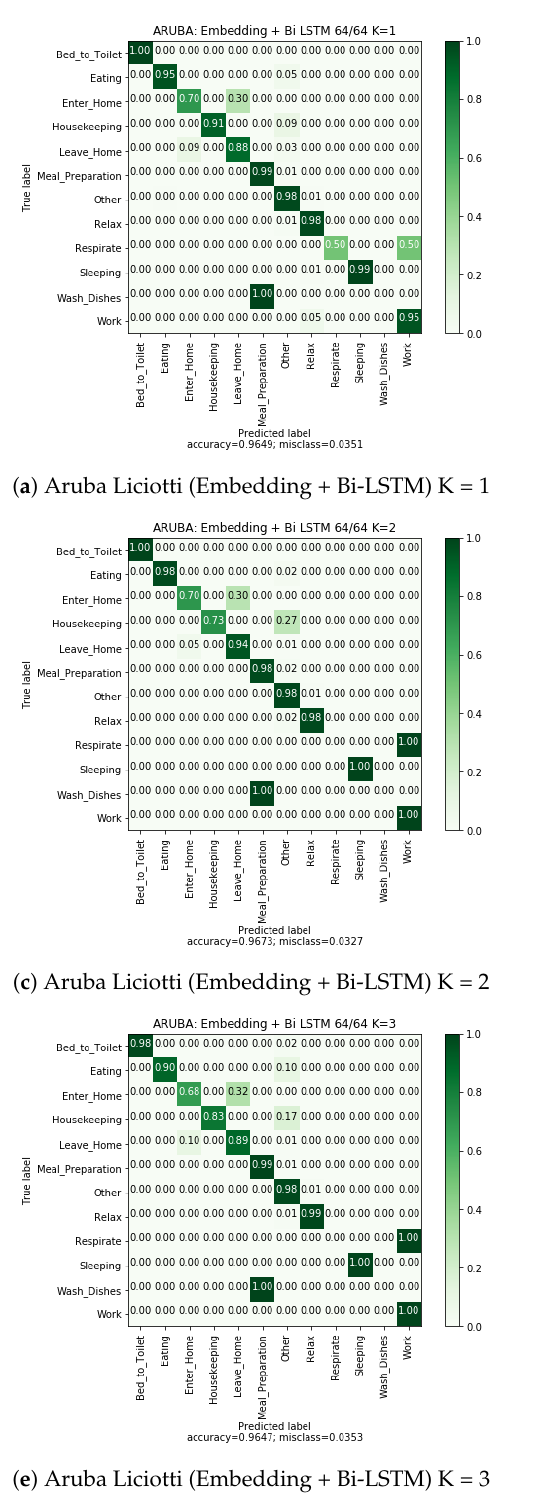
Figure A1. Aruba confusion